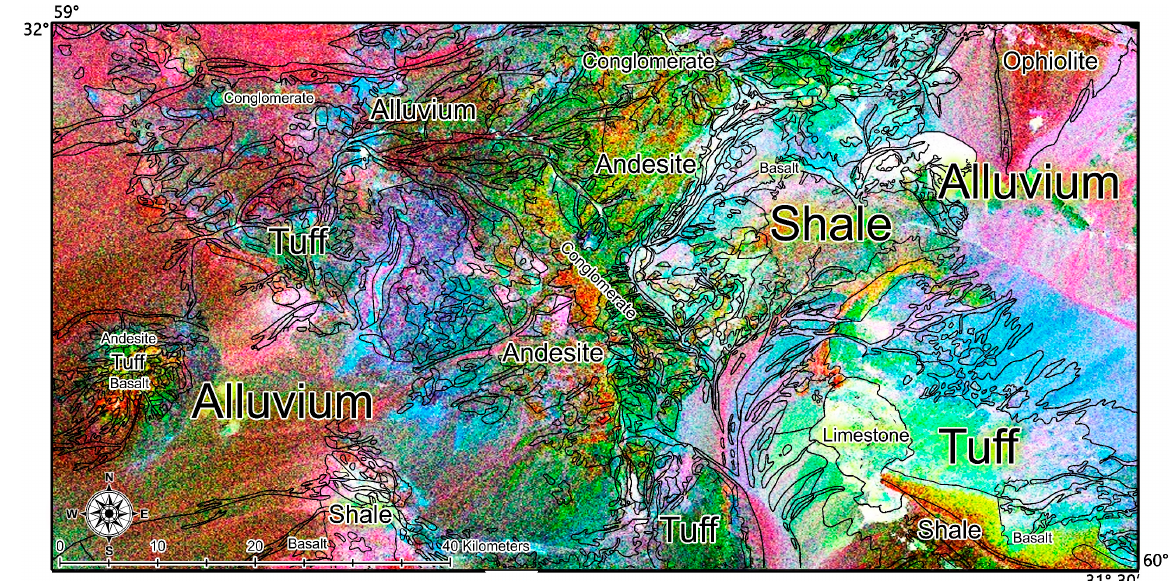
Figure 6. The image resulting from the band ratio combination (RGB = 5/7, 3/4, 3/1) on the ETM + satellite sensor.